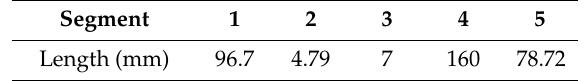
Table 2. Basic lengths of segments between scheme components at a temperature of 20 ◦